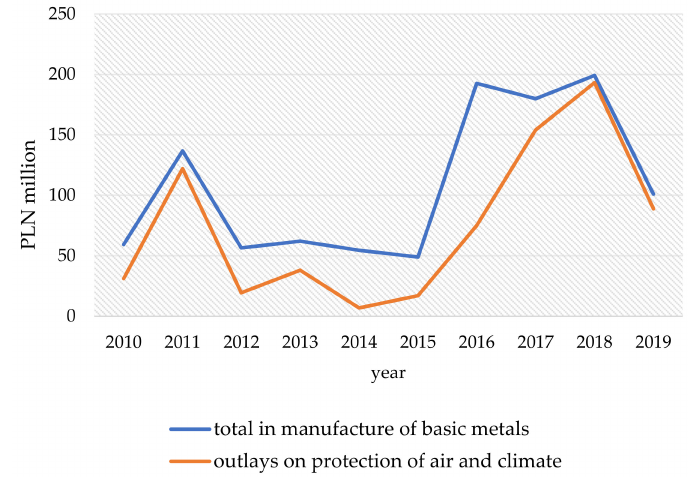
Figure 13. Amount of fixed assets in environmental protection in manufacture of basic metals by investment in Poland. Source: adapted with permission from Refs. [101–109].